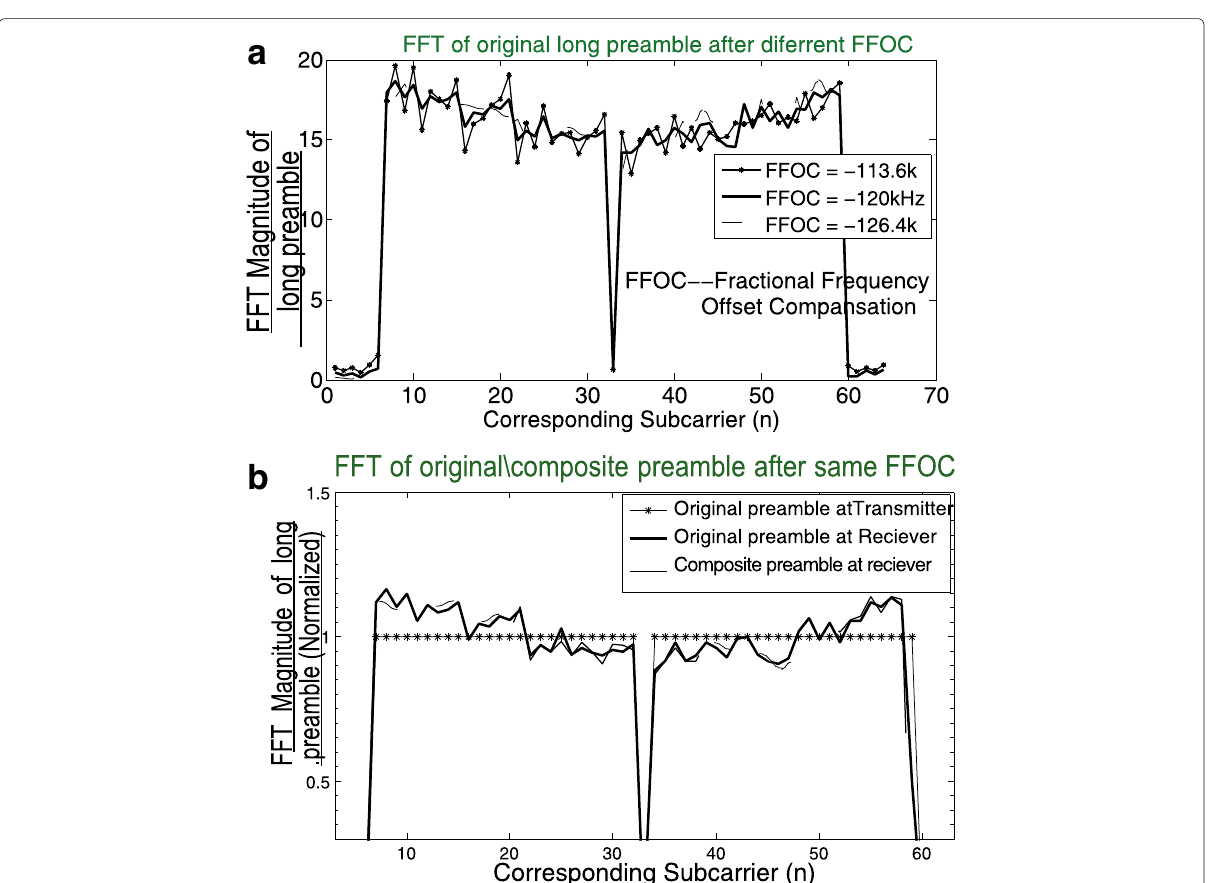
of the FDTD simulation were set as 2.9 × 1.5 × 2 m based on our lab, where the distance between the RX and TX antennas is 1.6 m and the length of an antenna is 12 cm. The sensed object is placed in the middle. Figure 5 shows the FDTD scenario.